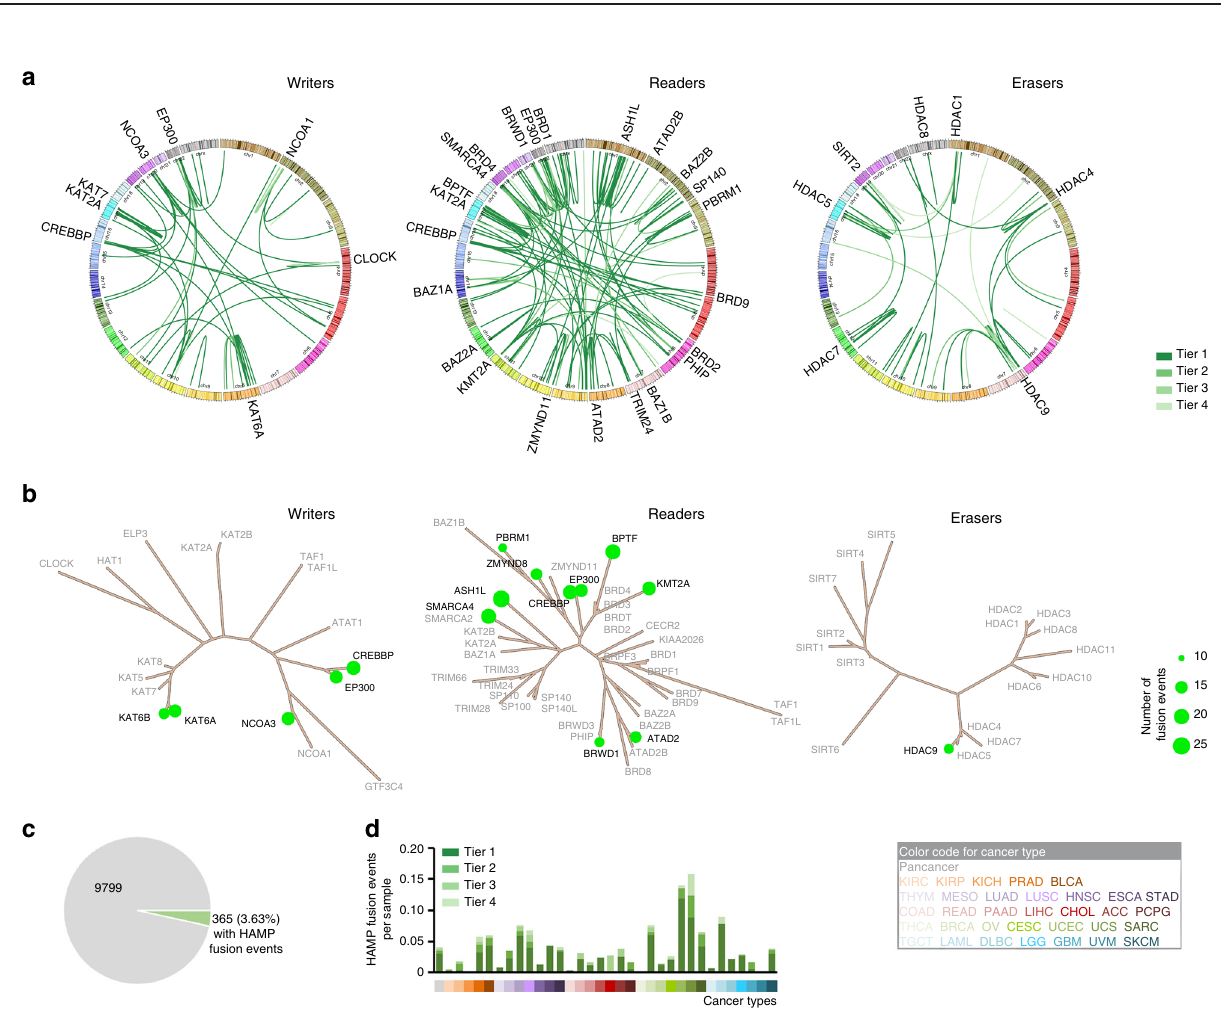
Fig. 6 Transcript fusions of HAMPs across cancers. a The fusions of HAMPs in TCGA samples are shown in Circos plots. The fused genes are illustrated as lines that connect two parental genes. The intensity of the line corresponds to the tier of the fusion event. b Summary of the HAMP transcript fusions across cancers. The size of the bubble: number of the HAMP transcript fusion events across 33 cancer types. The HAMPs coding in black and gray indicate a gene with fusion events ≥ 10 and < 10, respectively. The phylogenetic trees were generated by multiple sequence alignments of the full-length sequences of the proteins. c Percentage of tumor specimens with HAMP transcription fusion events across all cancer types. d Percentage of tumor specimens with HAMP transcription fusion events in each cancer type